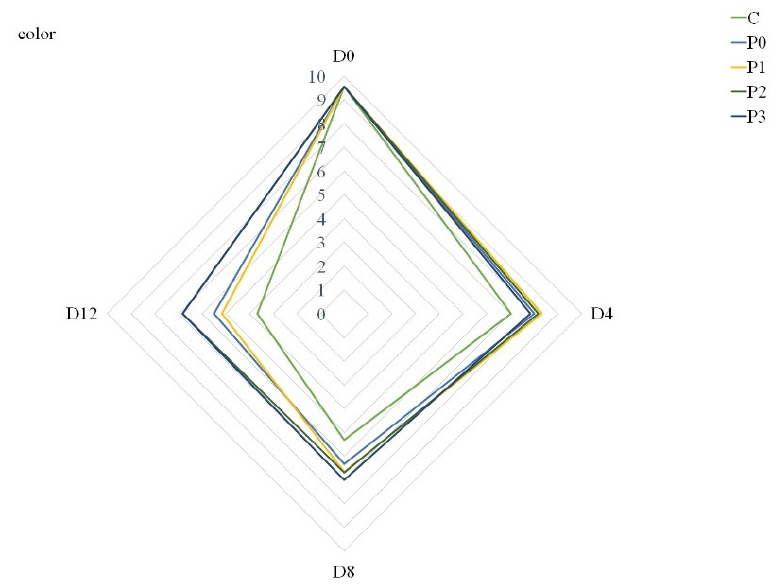
Figure 1. Color of stored samples (C—uncoated pork loins; P 0 —gelatin-coated pork loins; P 1 —gelatin-coated pork loins with the addition of 1% propolis extract to gelatin coating; P 2 —gelatin-coated pork loins with the addition of 2% propolis extract to gelatin coating; P 3 —gelatin-coated pork loins with the addition of 3% propolis extract to gelatin coating; D0—Day 0; D4—Day 4; D8—Day 8; D12—Day 12).